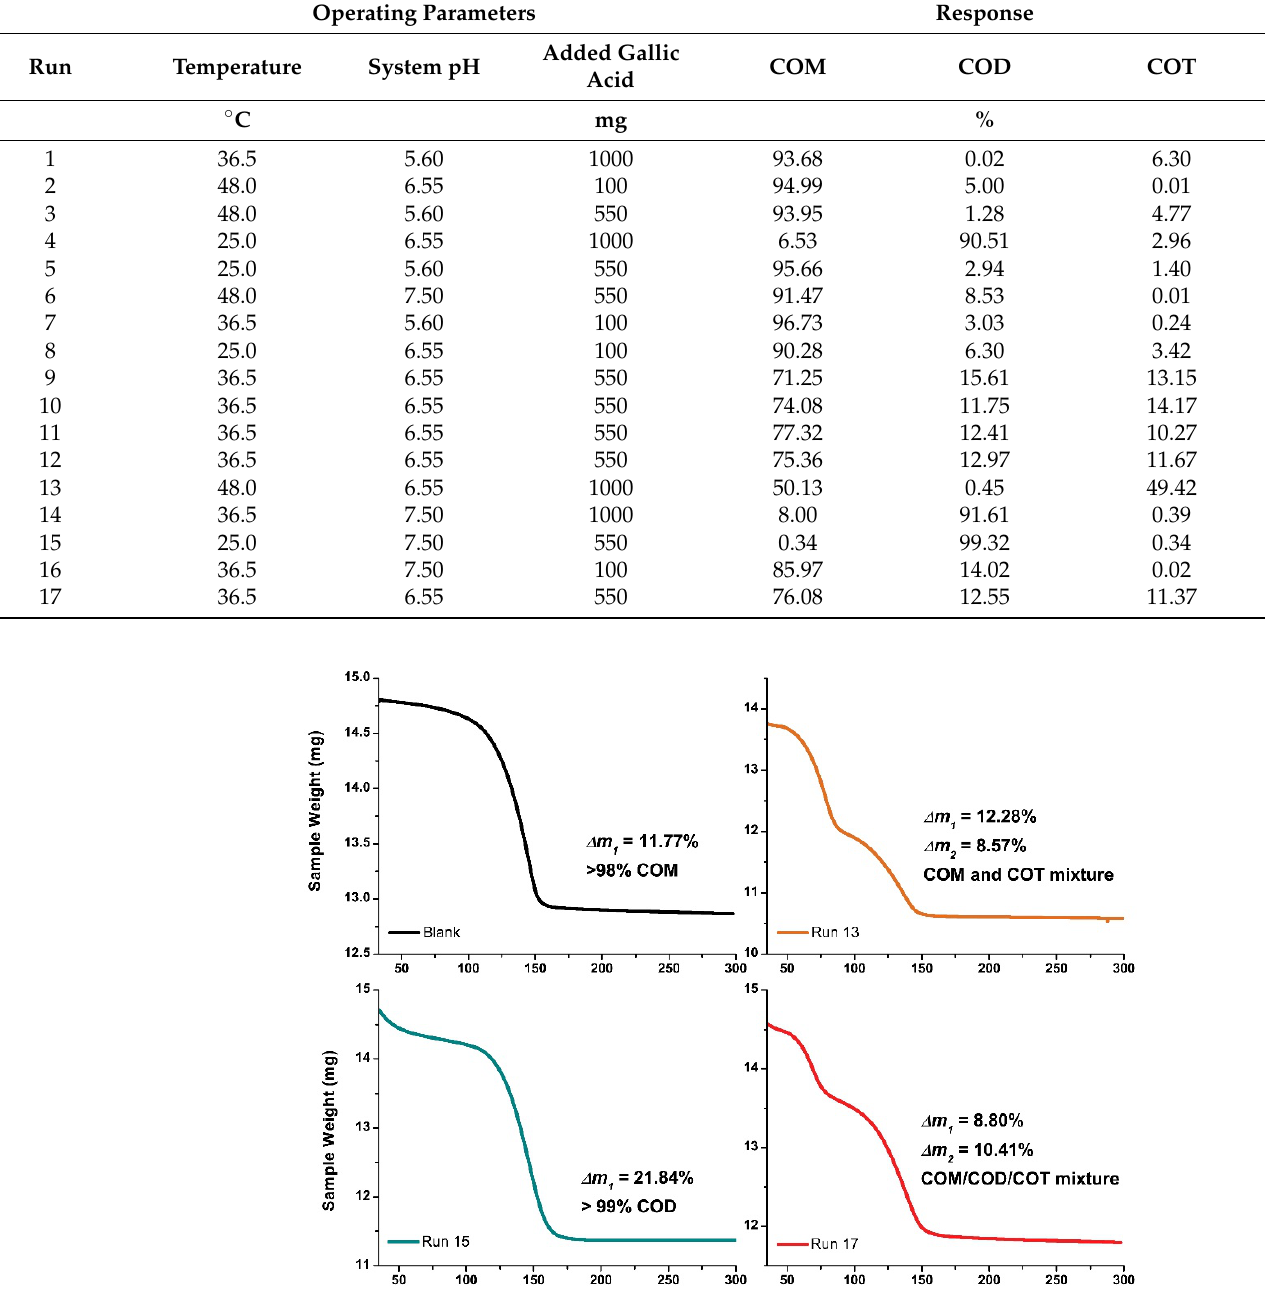
Table 2. Experimental Box–Behnken design and identification of each individual calcium oxalate hydrate phase by XRD technique, presented as response or dependent variable ( y ).